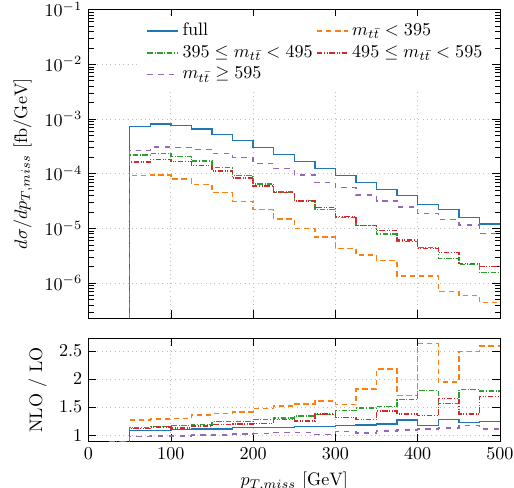
Figure 10 . The pp e + (cid:23) e (cid:22) (cid:0) (cid:22) (cid:23) (cid:22) b (cid:22) b (cid:23) (cid:28) (cid:22) (cid:23) (cid:28) + X double di(cid:11)erential cross section distribution as a ! function of p miss and m at the LHC run II with p s = 13 TeV. The upper plot shows absolute t (cid:22) t T NLO QCD predictions. The lower panel presents di(cid:11)erential (cid:22) 0 = m t + m Z = 2 are employed.